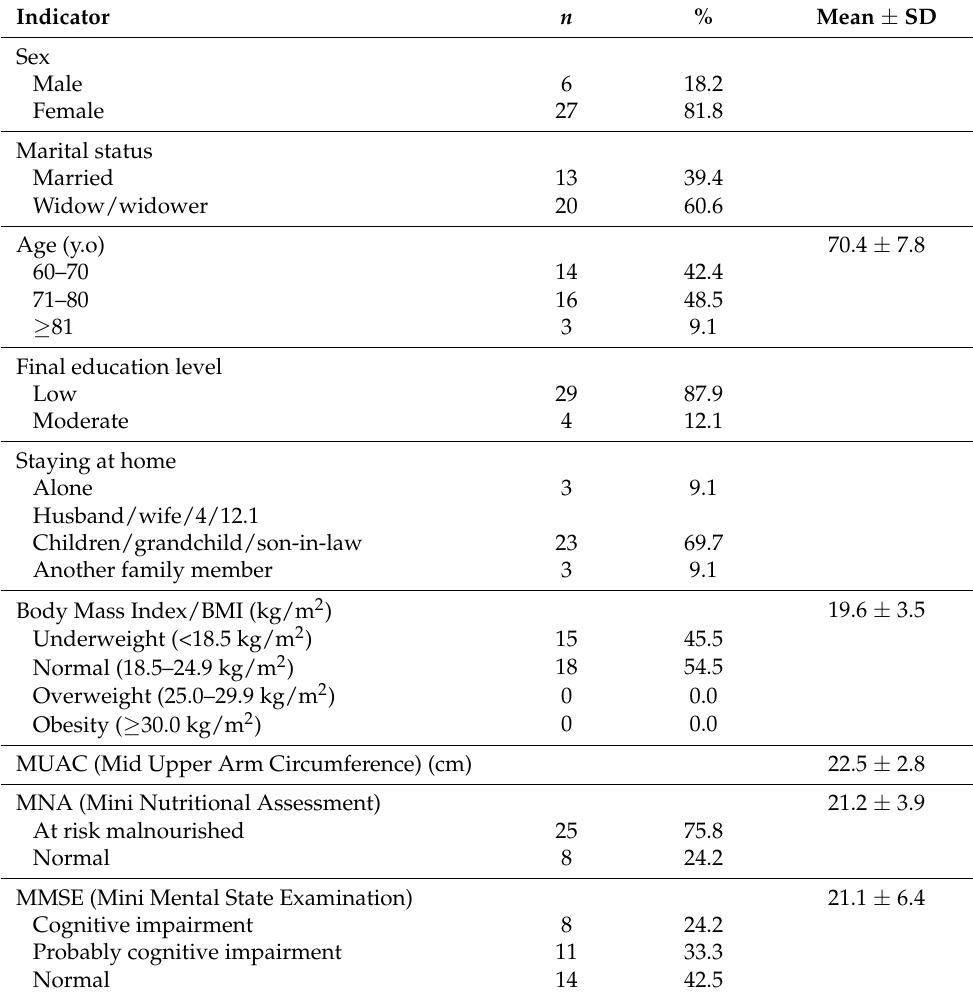
Table 3. Characteristic of socio-demography, nutritional status, cognitive performance, and level of independence